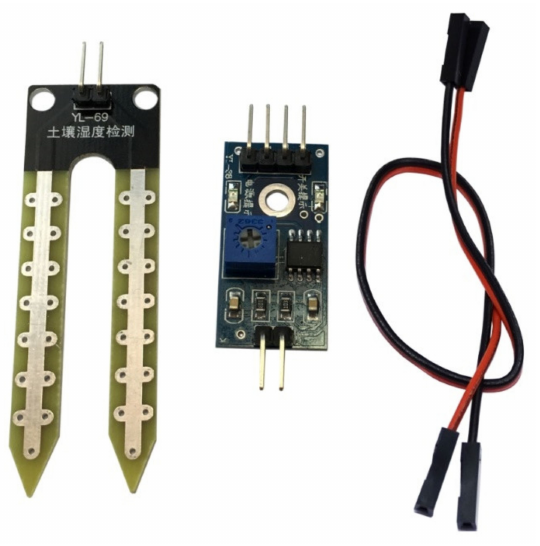
Figure 4. A typical YL-69 sensor, with necessary parts